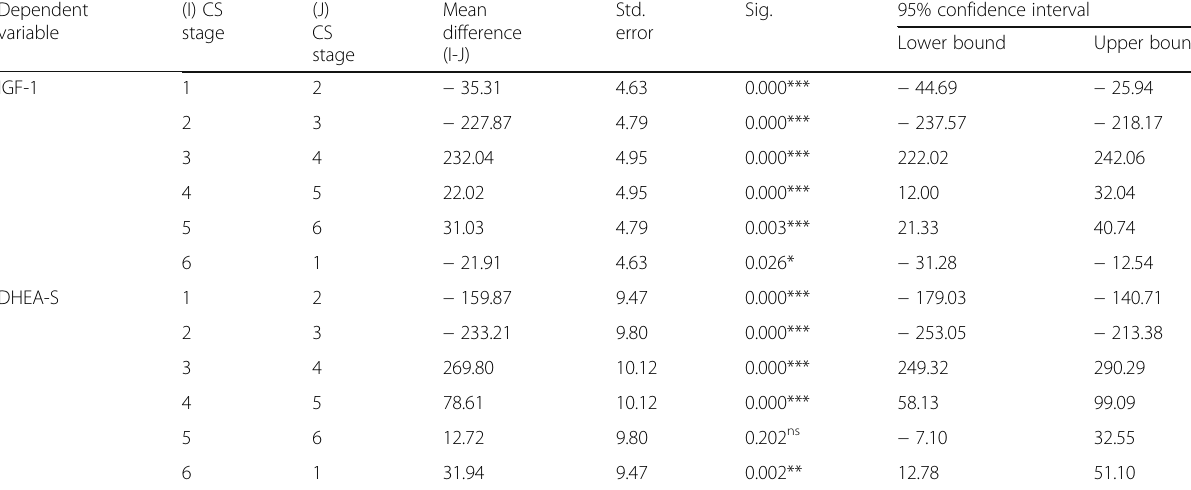
Table 4 Comparison of IGF-1 and DHEA-S levels in between the CS stages using the LSD test in group B Dependent variable